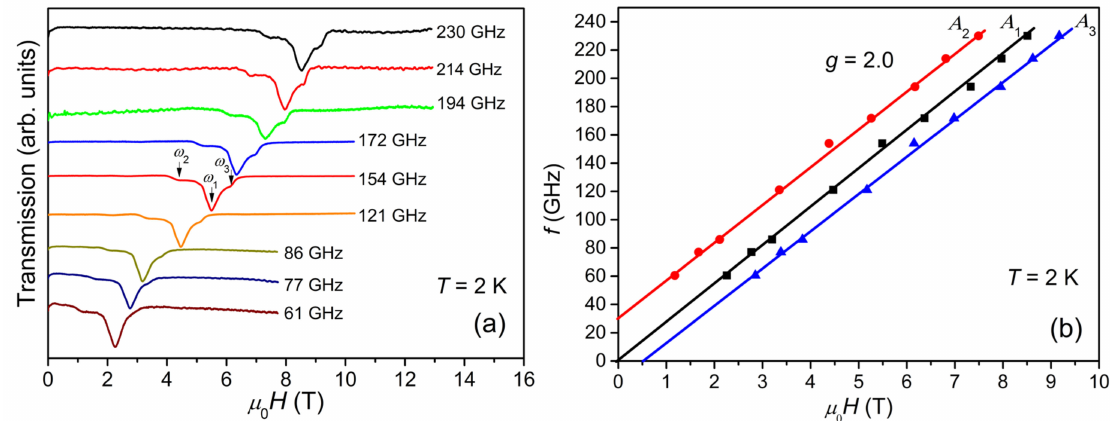
Figure 5. ( a ) ESR spectra collected at 2 K with frequencies varying from 61 to 230 GHz. ( b ) The f - H diagram: black squares, red circles, and blue triangles correspond to the central peak, A 1 , low-field peak, A 2 , and high-field peak, A 3 , respectively. The solid straight lines represent linear fits to the corresponding f - H